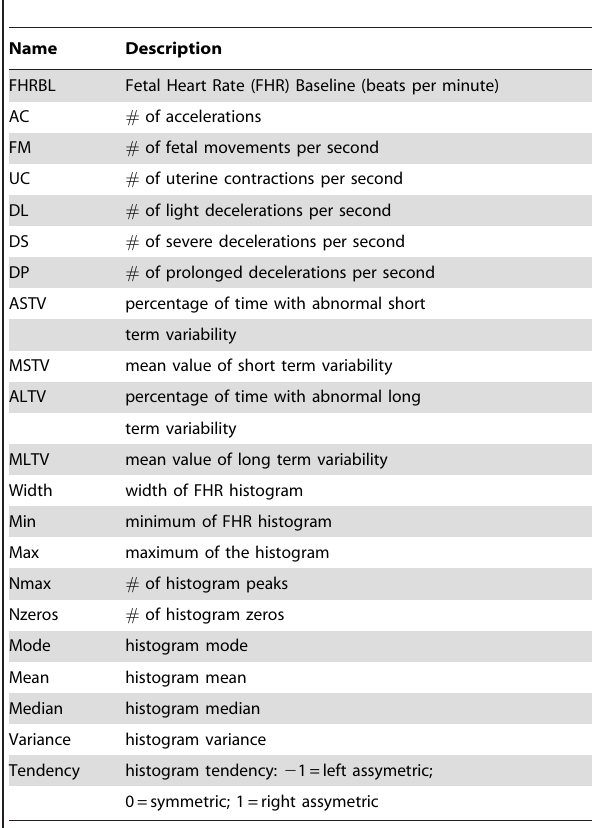
Table 4. The 21 CTG attributes used to predict potential fetal